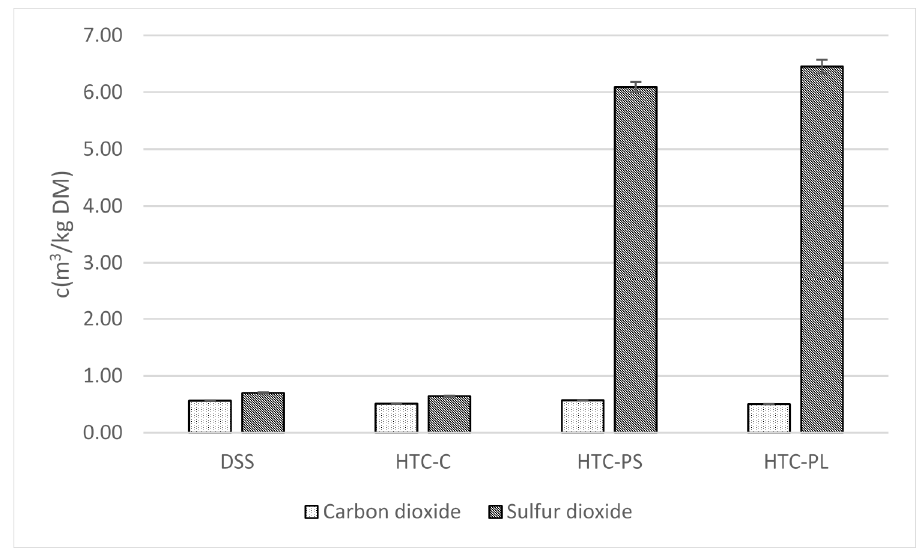
Figure 2. Volumetric carbon dioxide and sulfur dioxide emission per kg dry matter (DM) (Error bars show standard deviation of n = 2). Table 1. Ultimate analysis and higher heating values (HHV) of digested sewage sludge (DSS) and its derived hydrochars (HTC-xx). (C = Control; PS = P stripping; PL = P leaching; HC = Hydrochar) ( n = 2).